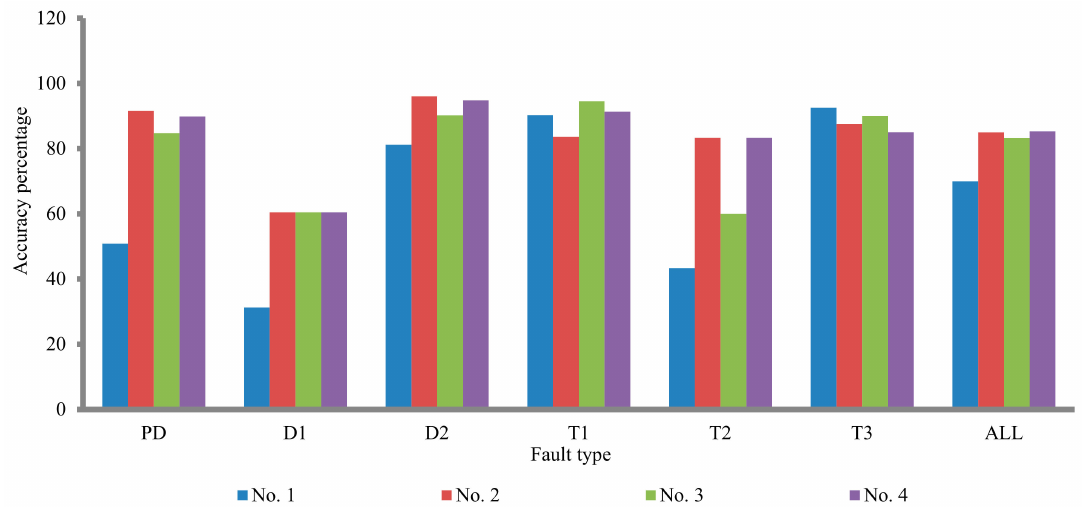
Figure 8. Comparison between the proposed DGA techniques.